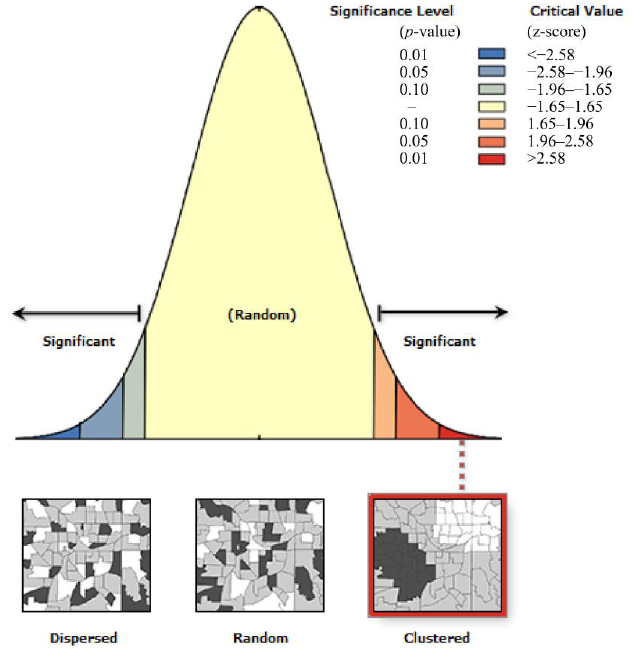
Land 2023 , 12 , x FOR PEER REVIEW Figure 11. Moran analysis of the spatial agglomeration of urban systems in China during the TCE. GIS software was used to classify the number of cities above the county level in China during the traditional period according to the provincial administrative regions to which they belonged (Figure 12), the results showed that Shanxi, Henan, and Zhejiang had the highest urban densities of 6.70, 6.26, and 6.09 cities/10 4 km 2 , respectively. Provincial ad- ministrative regions with relatively low urban densities included Inner Mongolia, Xin- jiang, Qinghai, and Tibet. A kernel density analysis of the urban density showed a contig- uous area of highly concentrated urban density forms in the regions of the North China Plain, Shanxi, and the Guanzhong Plain in northern China, and these were also the pri- mary urban agglomeration areas in China during the traditional period. In addition, small areas of high urban density formed in the Yangtze River Delta and the Chengdu Plain.